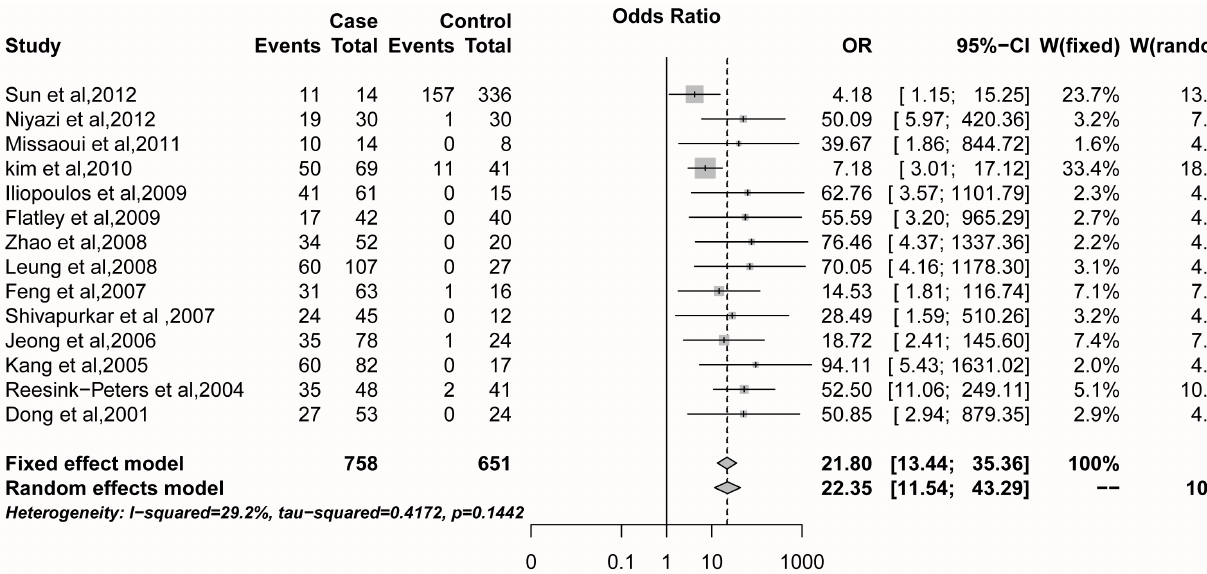
Figure 4. Pooled OR value of 14 studies omitting one heterogeneous study (Yang et al., 2010).